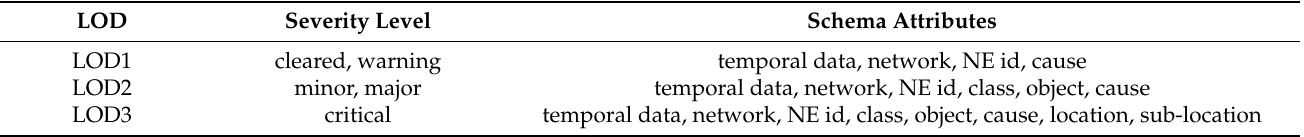
Table 4. Level-Of-Detail (LOD) defined as association between severity level and schema attributes.